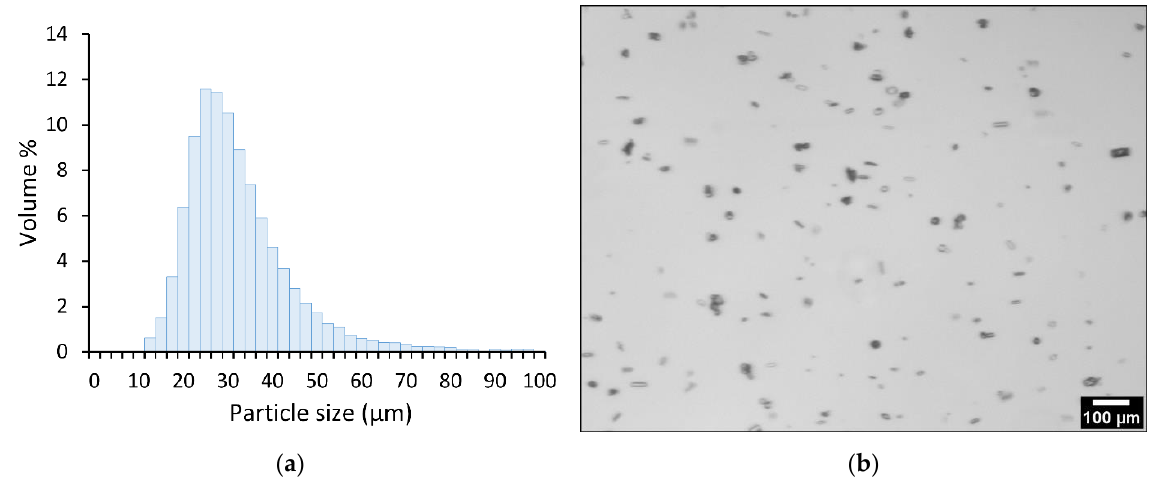
Figure 4. ( a ) Particle size distribution of the particles exiting the nucleator during the first 10 min of the experiment; ( b ) microscope image of particles exiting the nucleator using the inline microscope.